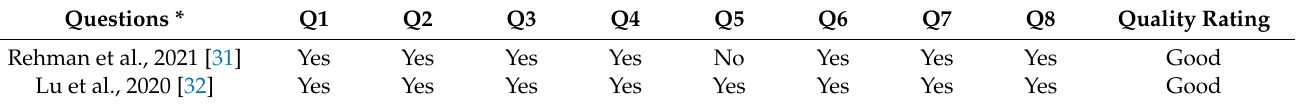
Table 4. Quality assessment of case